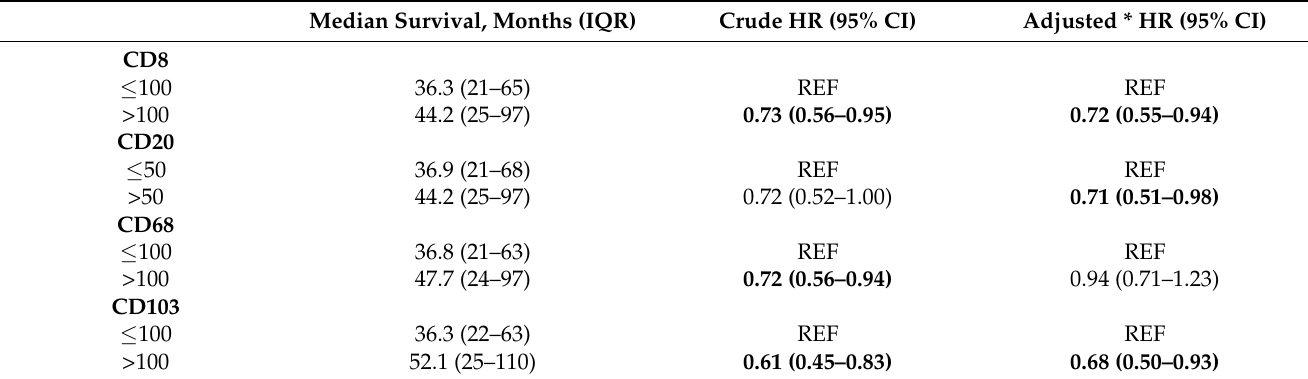
Table 4. Overall survival analysis, immune cell